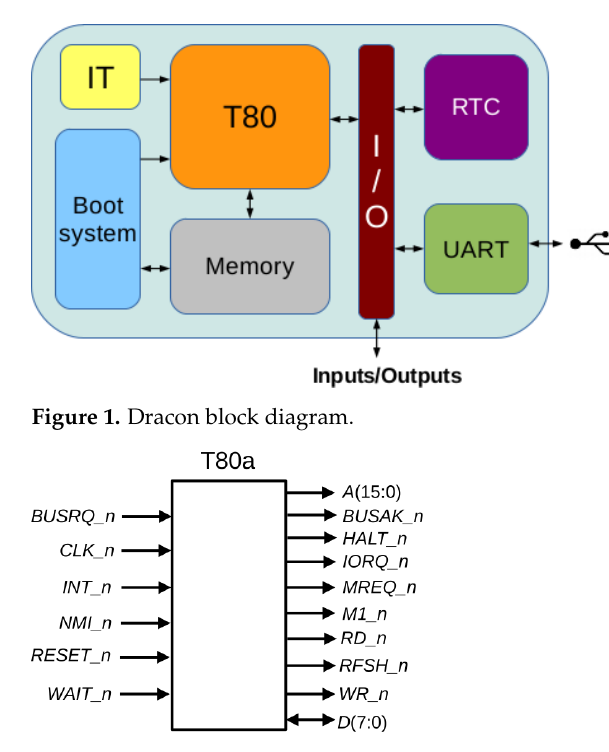
Figure 2. T80a pinout.